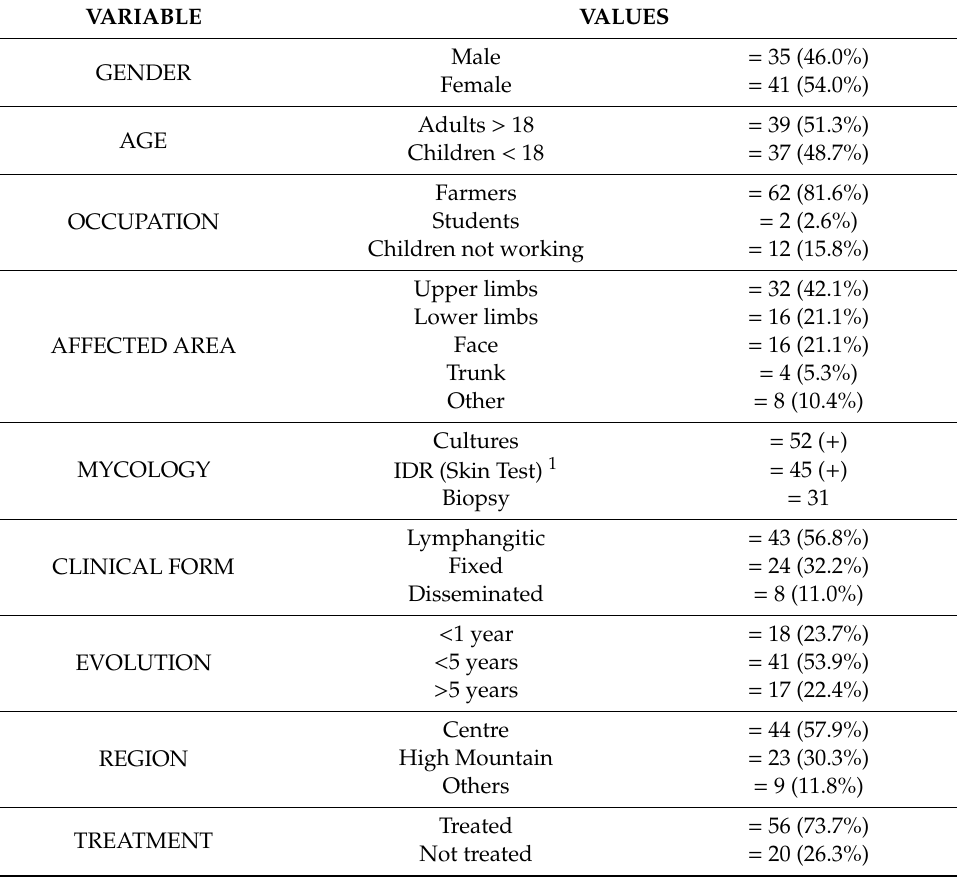
Table 2. Sporotrichosis